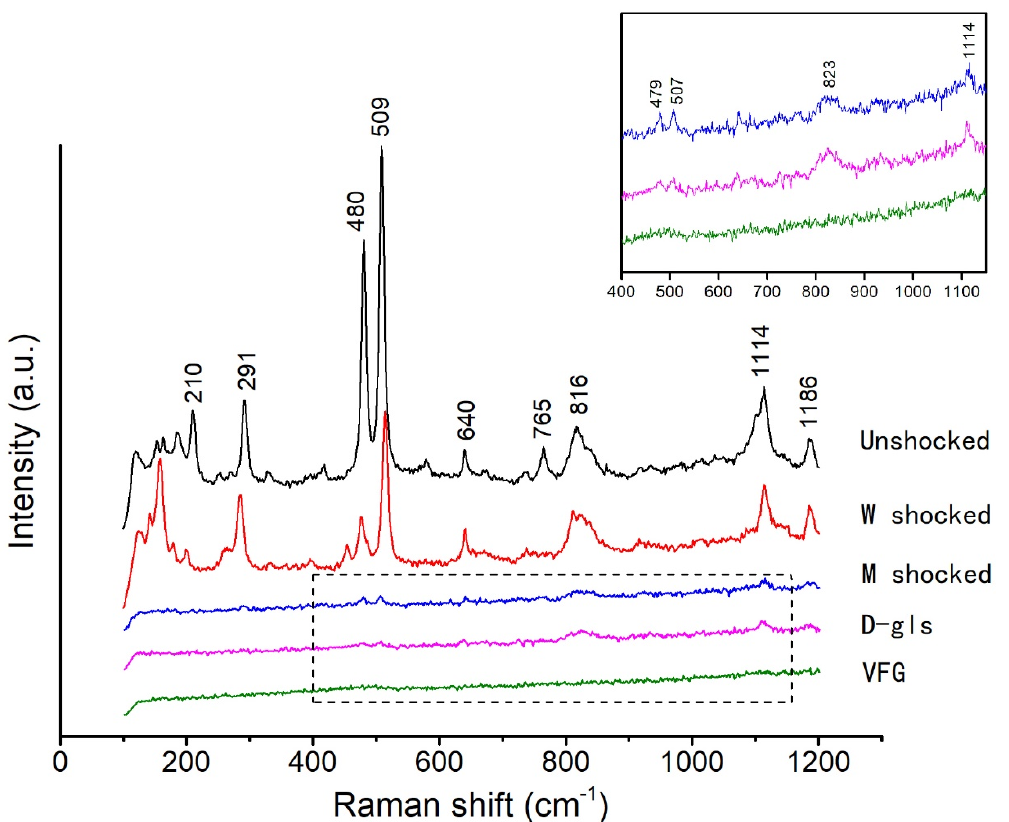
Figure 3. Representative Raman spectra of shocked feldspars. From top to bottom: unshocked feldspar (Unshocked), weakly shocked feldspar (W shocked), moderately shocked feldspar (M shocked), diaplectic feldspar glass (D-gls) and vesicular feldspar glass (VFG). The inset represents the area indicated by dashed box. Table 1. Representative contents of major elements (wt%) in weakly shocked feldspars, moderately shocked feldspars and melt glasses.